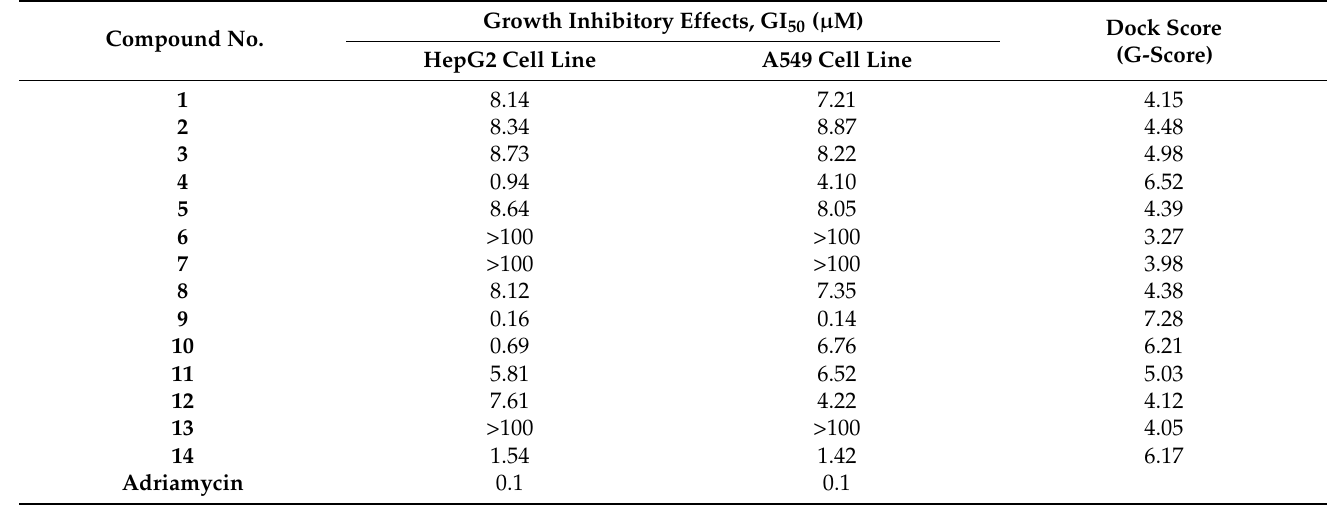
Table 2. In vitro cytotoxic activity of synthesized compounds by SRB assay with their dock score or